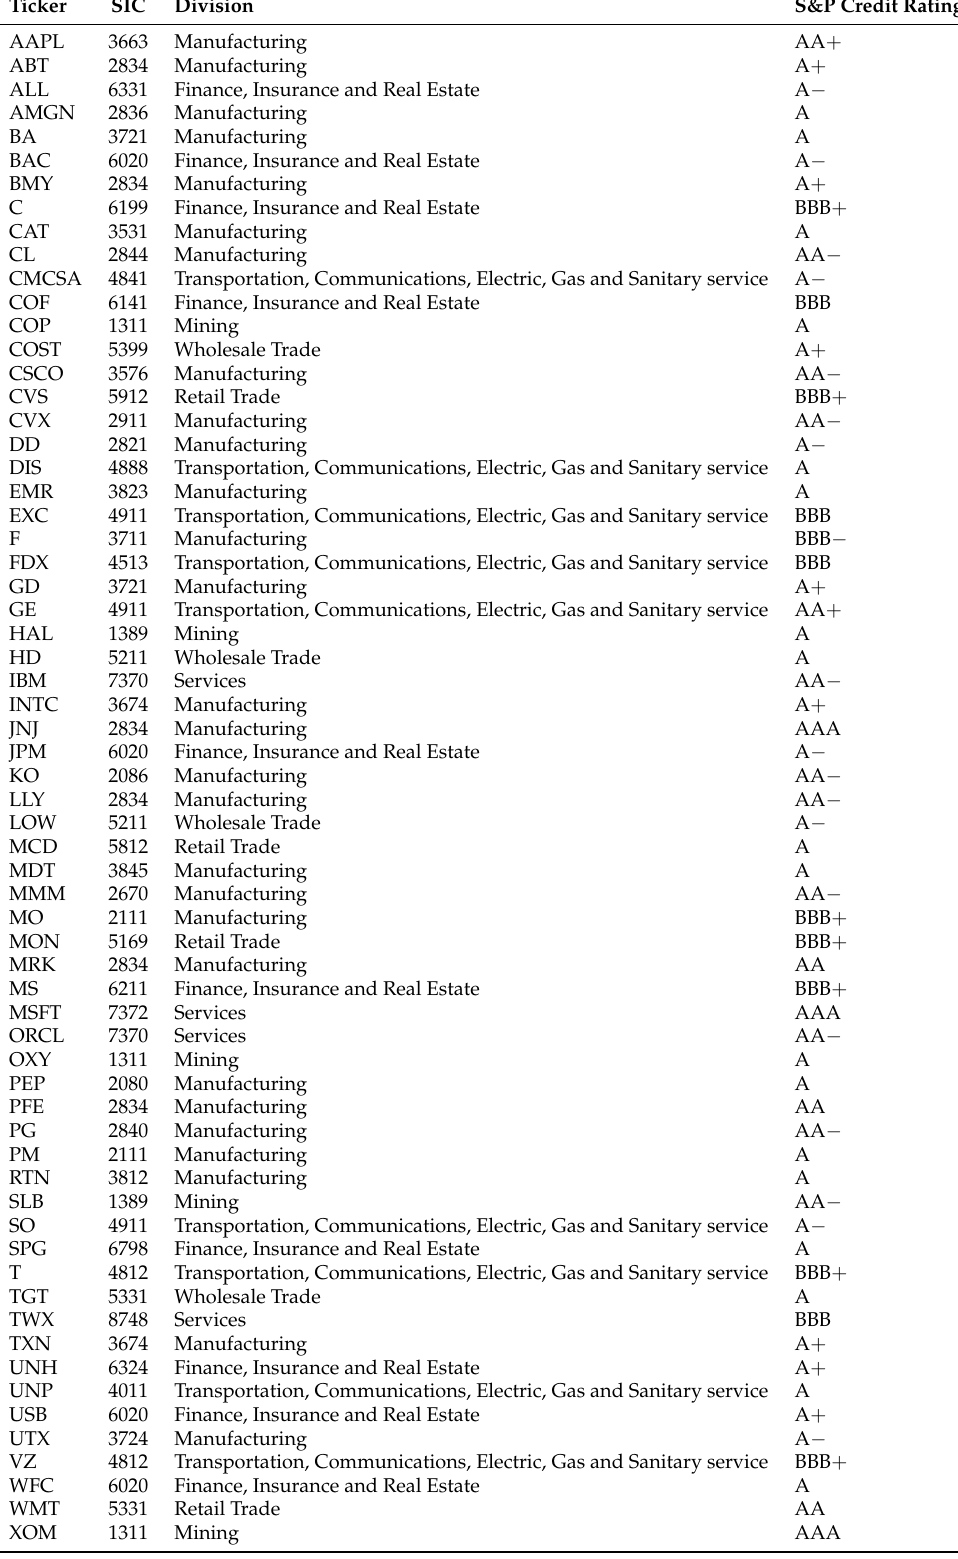
Table 1. List of the selected companies (ticker) and their SIC code. The sample is further divided into four categories based on the industry/type or business: (a) financial companies; (b) mining, energy and utilities companies; (c) manufacturing; (d) retail, wholesale and services. Credit ratings are obtained from Compustat and the mode of the ratings over January 2013 to Decemeber 2017 are